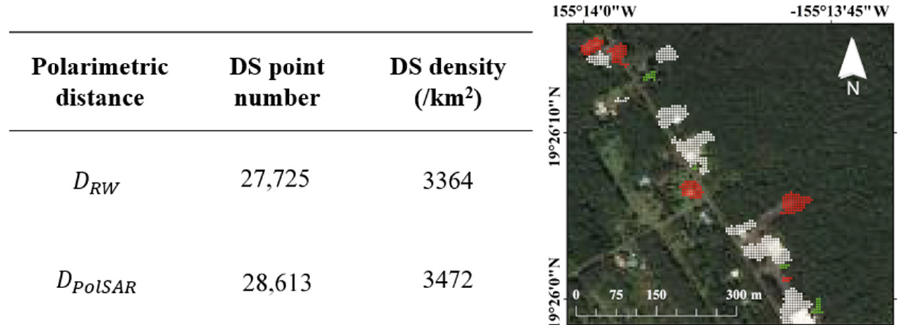
Figure 15. The results of polarimetric distances 𝐷 (cid:3019)(cid:3024) and 𝐷 (cid:3017)(cid:3042)(cid:3039)(cid:3020)(cid:3002)(cid:3019) . The local detail map of DSs (red Figure 16. The results of polarimetric distances 𝐷 (cid:3019)(cid:3024) and 𝐷 (cid:3017)(cid:3042)(cid:3039)(cid:3020)(cid:3002)(cid:3019) . The local detail map of DSs (red points: 𝐷 (cid:3017)(cid:3042)(cid:3039)(cid:3020)(cid:3002)(cid:3019) ; green points: 𝐷 (cid:3019)(cid:3024) ; white points: 𝐷 (cid:3017)(cid:3042)(cid:3039)(cid:3020)(cid:3002)(cid:3019) (cid:3404) 𝐷 (cid:3019)(cid:3024) ). points: 𝐷 (cid:3017)(cid:3042)(cid:3039)(cid:3020)(cid:3002)(cid:3019) ; green points: 𝐷 (cid:3019)(cid:3024) ; white points: 𝐷 (cid:3017)(cid:3042)(cid:3039)(cid:3020)(cid:3002)(cid:3019) (cid:3404) 𝐷 (cid:3019)(cid:3024) ). points: D PolSAR ; green points: D RW ; white points: D PolSAR = D RW ).